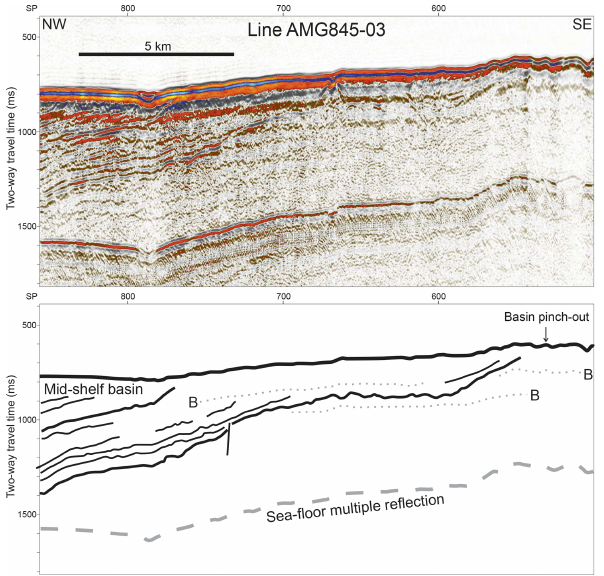
Figure 3. Part of MCS Line AMG845-03 and interpreted line draw- ing, showing sedimentary basin pinch out at ∼ SP530. Dotted grey lines labelled B on the line drawing mark prominent bubble pulse reverberations following the sea-floor reflection. Location of pro- file, including shot point positions, shown in Fig. 2a.